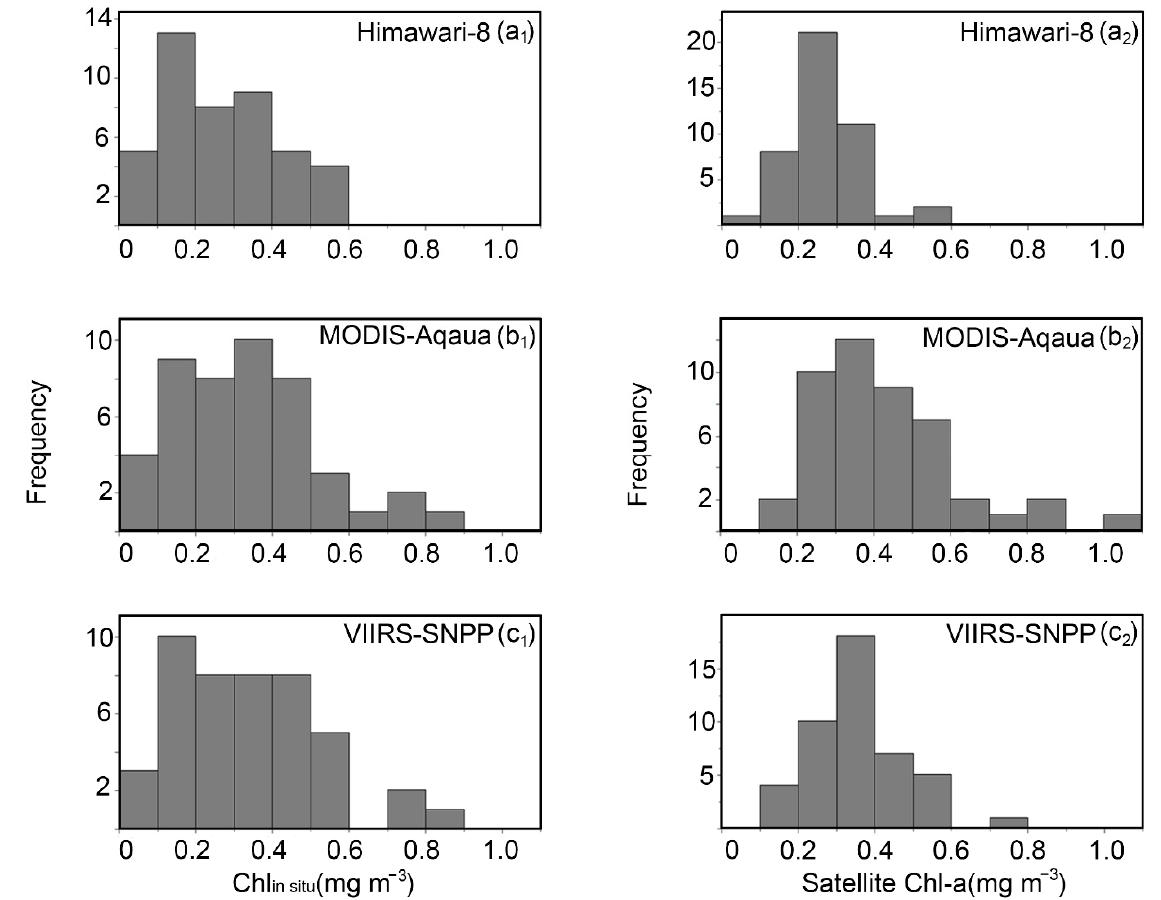
Figure 3. Frequency distribution histogram of in situ data and satellite data. ( a 1 – c 1 ) show the distribution of in situ data, and ( a 2 – c 2 ) show the distribution of satellite Chl-a data. Table 3. Summary of in situ data and satellite data matchup results. The selected combinations and the basis of each selection are highlighted in red bold.